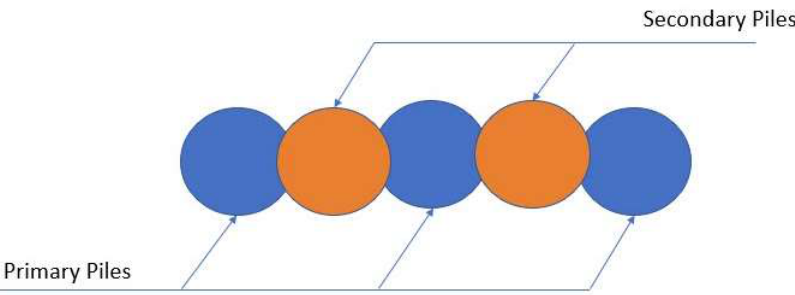
Figure 1. Construction of a secant pile wall system.